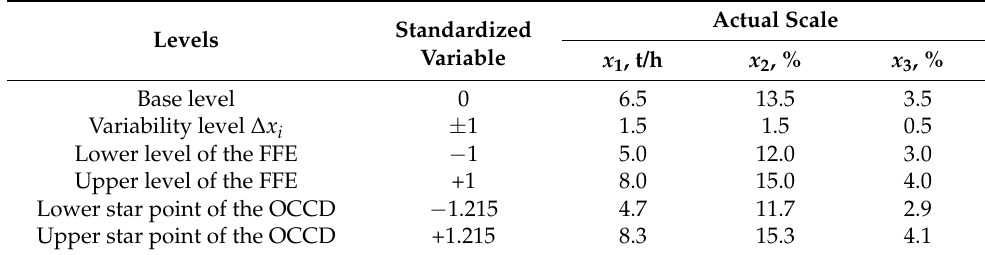
Table 1. Factor levels and factor variability intervals for ZAV-20 (one production line without disc